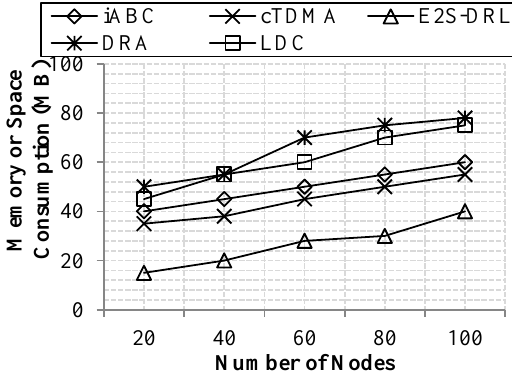
Figure 10. Comparison of memory or space analysis.